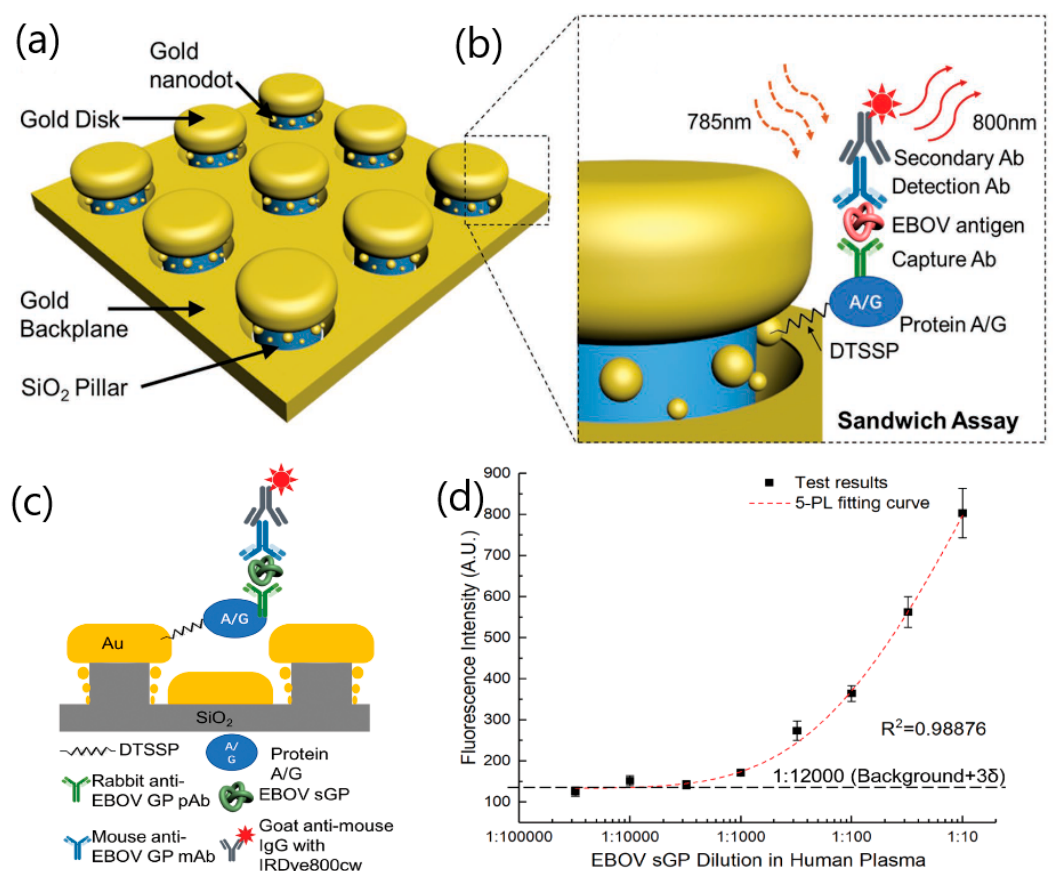
Figure 11. The Ebola virus sensor nanostructures and fluorescence sensing methods. ( a ) Schematic of nanoantenna array. ( b ) Exploded view showing the details of single nanopillar structures and a sample Ebola virus sandwich assay structure on chip. Ebola virus soluble glycoprotein (EBOV-sGP))-spiked human plasma study using the nanoantenna array biosensor. ( c ) EBOV sGP sandwich assay format. ( d ) Calibration curve of sGP tested on the nanoantenna array (N = 27, error bars stand for